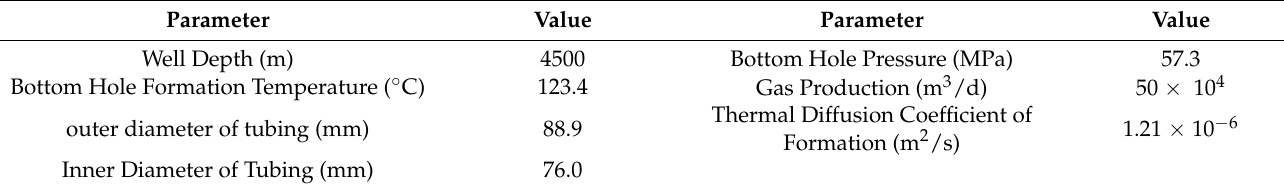
Table 3. Calculation data for model validation.